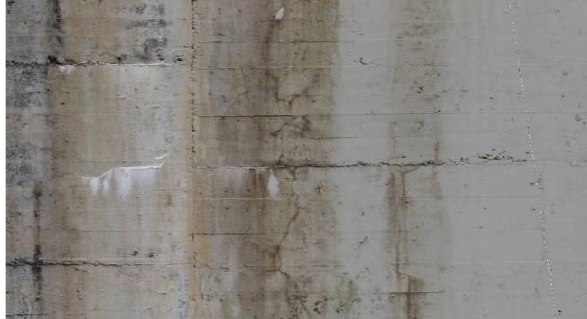
Figure 3. Picture of a defect captured with SCANSITES ®